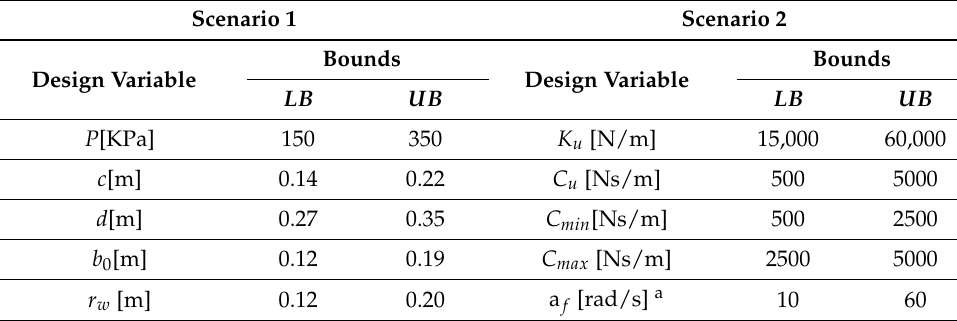
Table 4. Design variables and their bounds for Cases 1 and